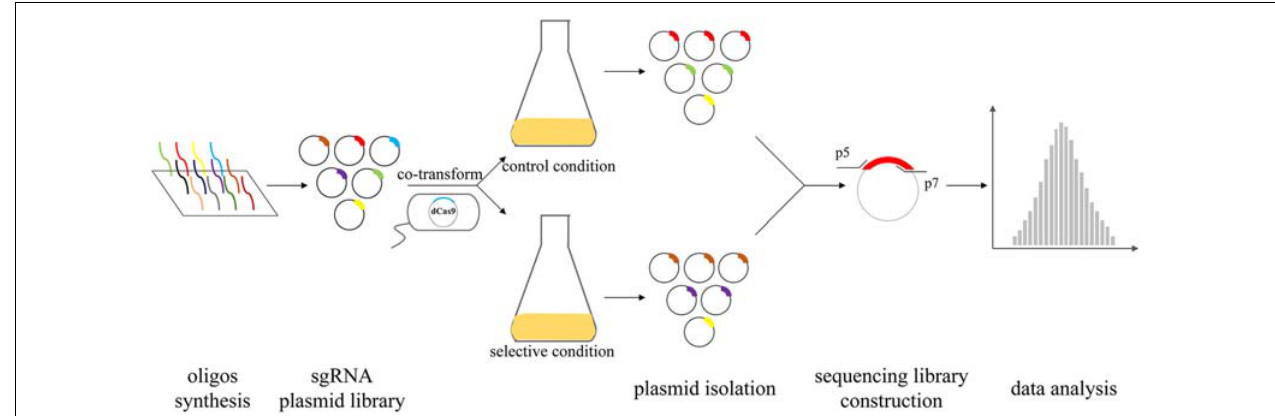
FIGURE 2 | The CRISPRi screening procedure in bacteria. Firstly, oligos designed on a large scale by the software are synthesized through a chip and then, the sgRNA plasmids library is constructed. Mix sgRNA plasmids are co-transformed into recipient strains in which dCas9 is integrated into genomic DNA. Competitive growth culture is performed in selective condition and control conditions. The mixed plasmids are isolated from pooled colonized strain and subsequently used for high-throughput sequencing. Finally, data analysis of the relative fitness contribution of each gene is performed.